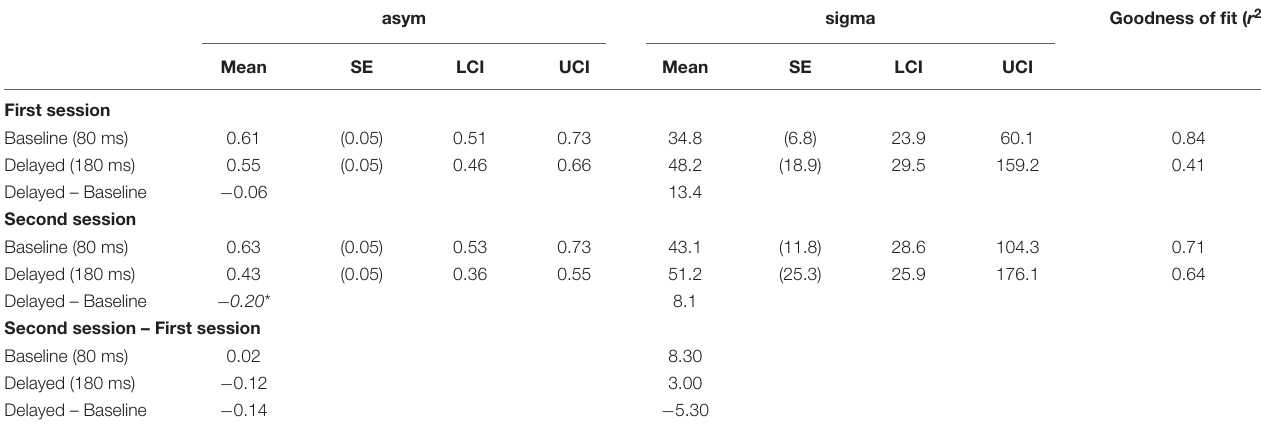
TABLE 4 | Estimated parameter values of the fitted linear regression of the mean rate of “self” response against the SD of asynchrony. asym sigma